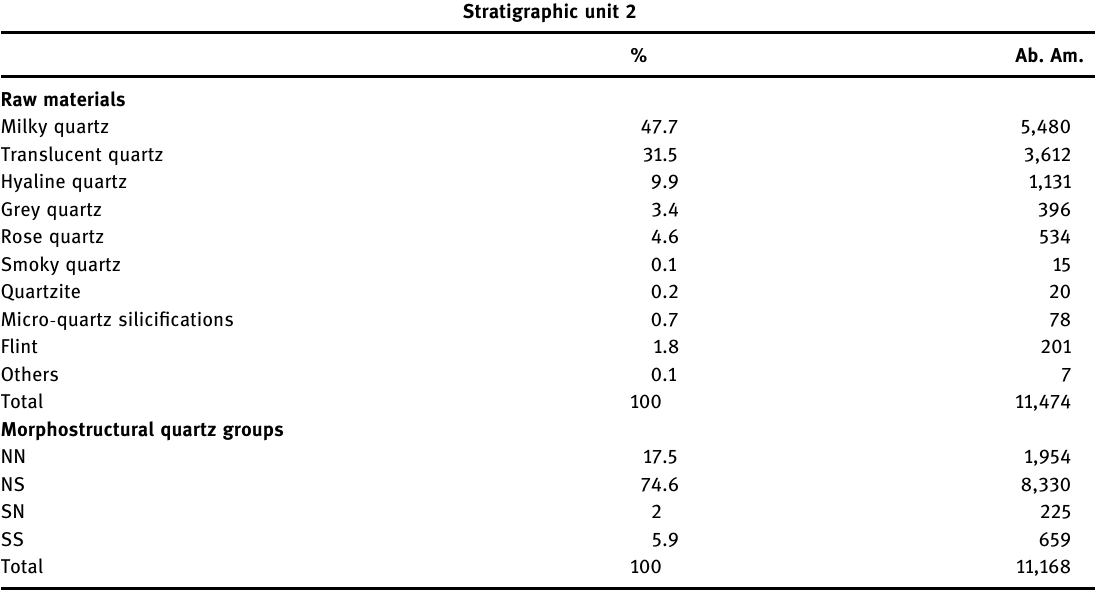
Table 4: Lithic industry SU - 2 ( technological categories )